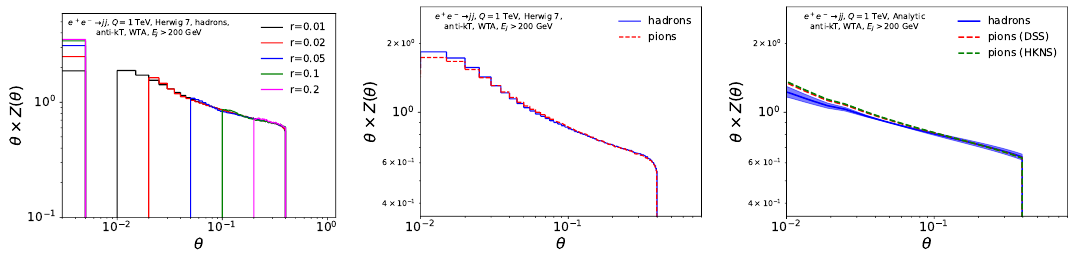
Figure 12 . Left panel: the jet shape using subjets (instead of hadrons) as input. The lowest bin gets its contribution from (cid:18) = 0. All the jet shapes were normalized by the same factor, taken to be the area of the r = 0 : 01 curve in (cid:18) = [0 : 1 ; 0 : 4]. Middle panel: the jet shape using all particles (blue) and only charged pions (red dashed) as input. The red-dashed pion distribution has been normalized to the blue curve for all particles to emphasize the similarity in the shape. Right panel: the analytic calculation of the jet shape for pions using two set of fragmentation functions: DSS or HKNS (red and green dashed respectively), compared to the full result